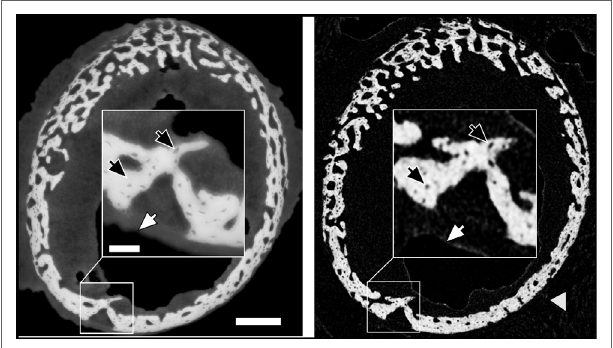
FigUre 1 | Comparison of similar cross-sections in a 10-day sample imaged by holotomography (left) and a laboratory source CT (right). The gray arrow head highlights gauze, which supports the bone during the lab CT scan. The scale bar equals to 200 µm. The inset shows a high magnification (scale bar = 50 µm) to highlight the differences in feature visibility between the methods. Dark arrows pinpoint osteocyte lacunae, and white arrows hint to the transition between soft tissue and